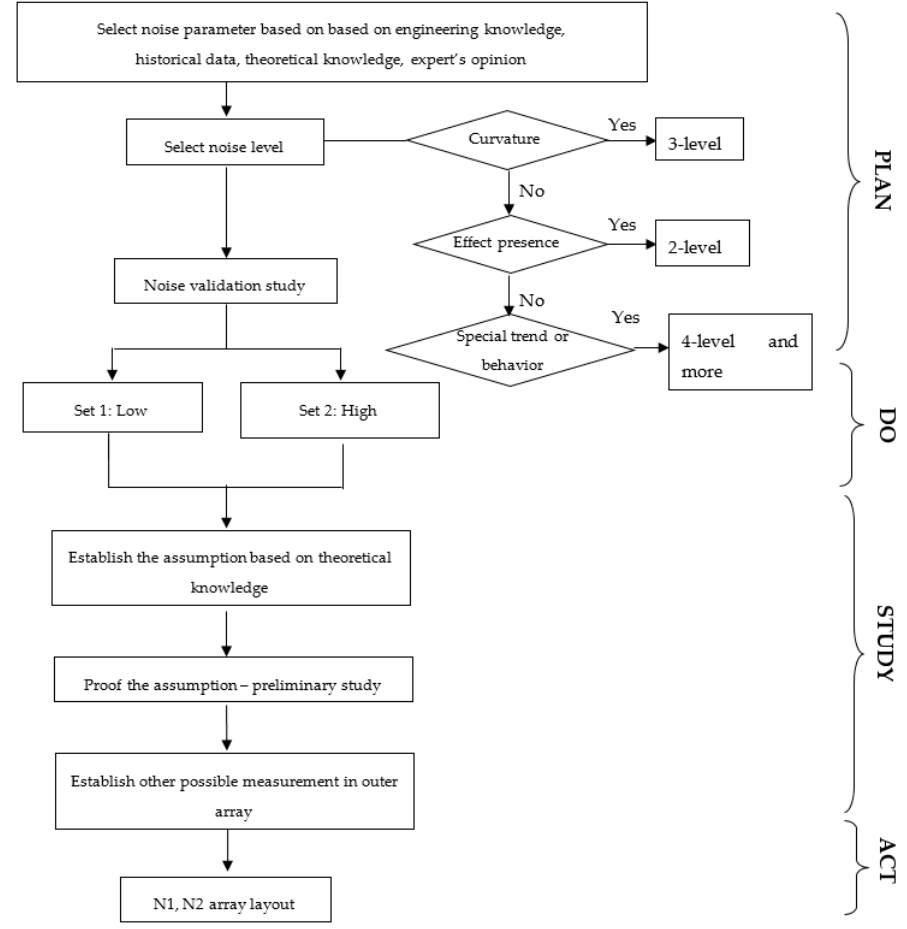
Figure 13. Noise (N) sub-system of F-N-C-O.